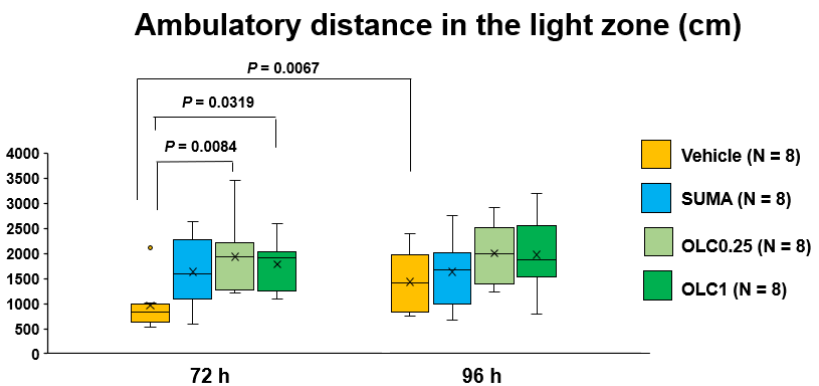
Figure 5. Ambulatory distance in the light zone in each group. Data are plotted in the box-and- whisker box. The ordinate shows the sum of ambulatory distance travelled in the light zone during the evaluation period. Statistical analysis was performed using the two-way repeated measures ANOVA with effective matching to evaluate the effects of time and pharmacological interventions. Multiple comparisons were made by Sidak’s test for identical groups between 72 h and 96 h and by Dunnett’s test for different groups at the same timepoint. N = 8 in each group. Vehicle: Vehicle group, SUMA: Sumatriptan group, OLC0.25: Olcegepant 0.25 mg group, OLC1: Olcegepant 1 mg